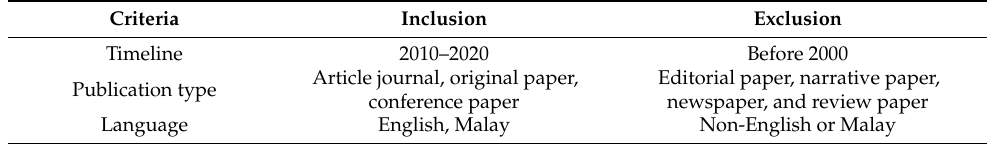
Table 3. The criteria for articles